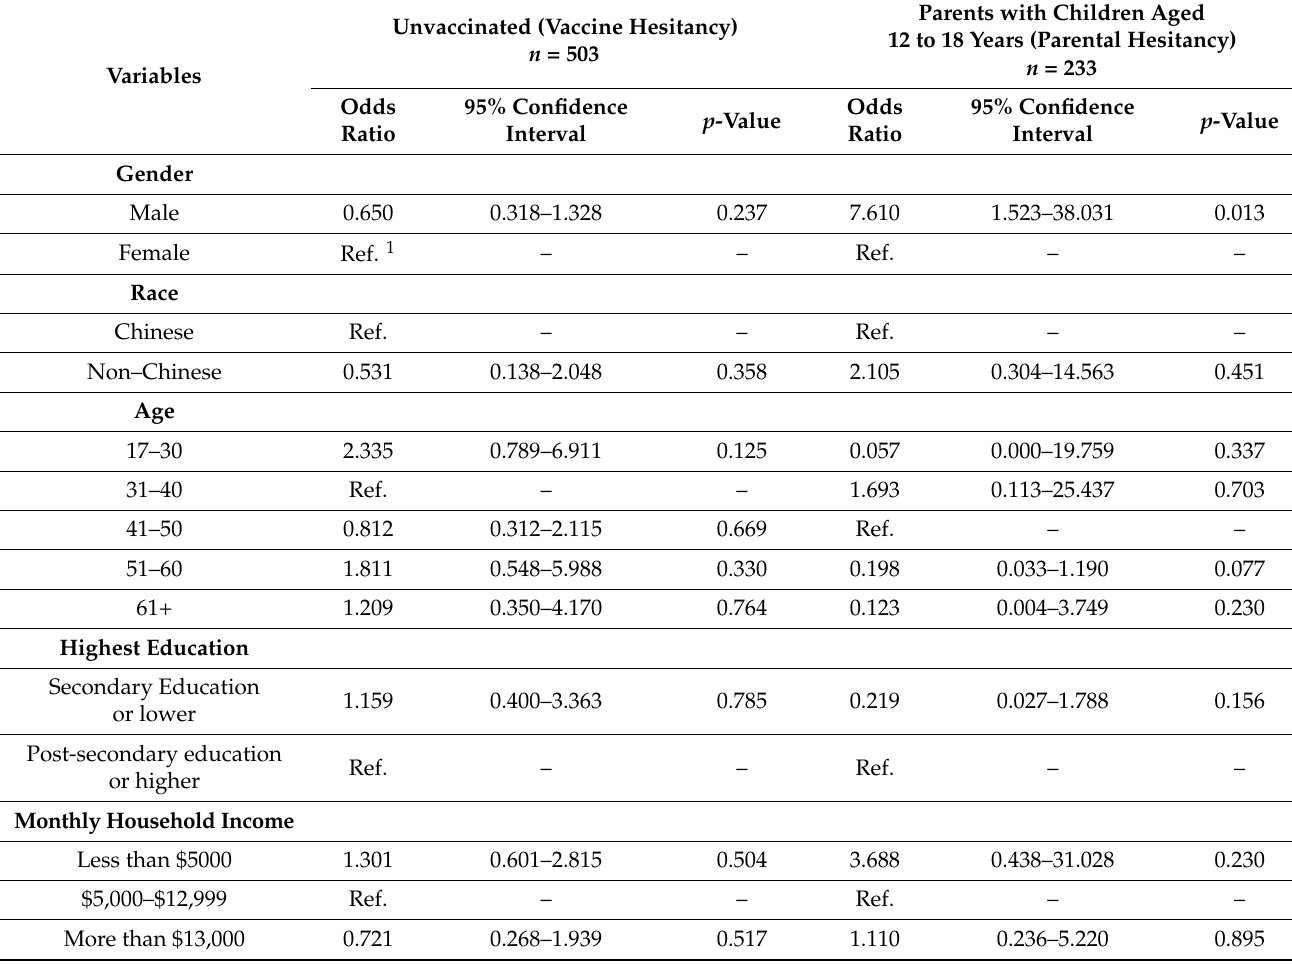
Table 3. Multivariable binary logistic regression analysis of vaccine hesitancy in unvaccinated participants ( n = 503) and parental hesitancy in parents with children between 12 to 18 years old ( n =